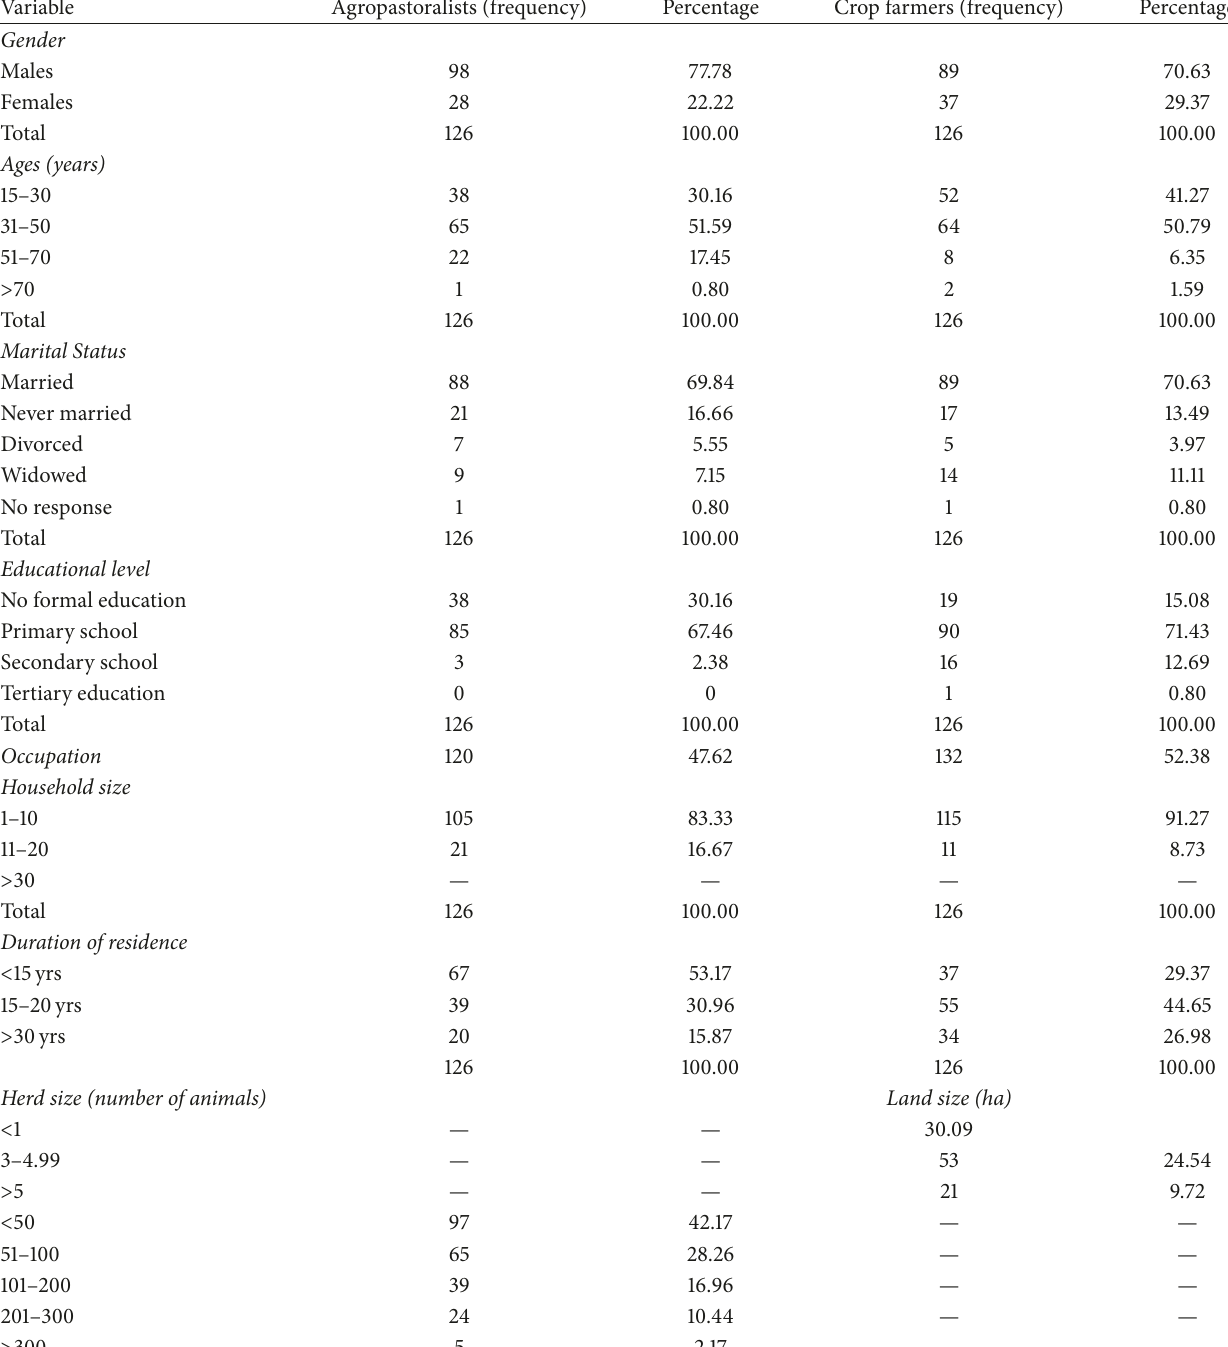
Table 3: Socioeconomic characteristics of respondents ( 𝑛 = 252